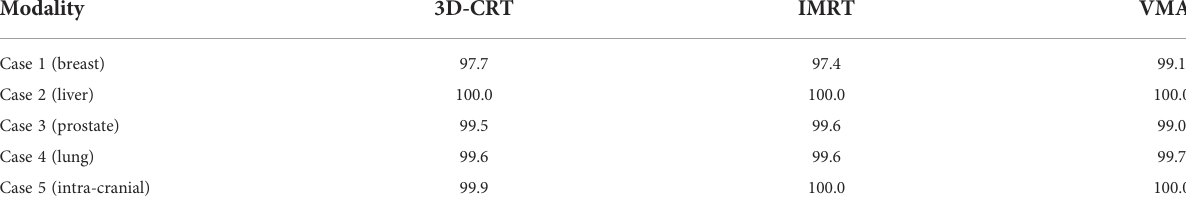
TABLE 6 3D Gamma passing rate (%) of 1%/1mm for clinical cases. Criteria = 1%/1mm.